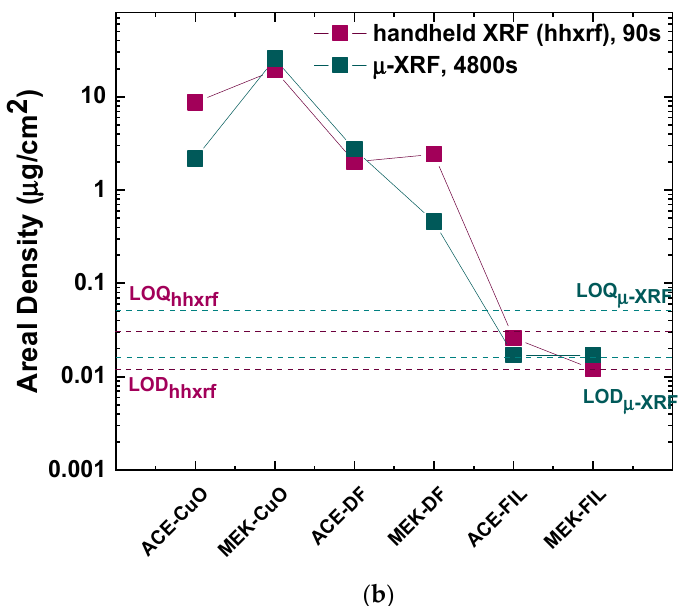
Figure 8. ( a ) Synopsis of µ -XRF measurements for all Phase 2 CuO/PMMA samples. The corresponding measurements of 1%CuO-1k and 1%CuO-1k-DF from Phase 1 have been included for comparison. Scattered solid diamonds depict the intensity signal from each point, while open squares show the average signal value. The large rectangles show the range between 25% and 75% of the maximum obtained signal, the crosses mark the range between 1% and 99% of the maximum obtained signal and the horizontal dashes the minimum and maximum obtained values. Dashed lines show the limit of detection (LOD) and the limit of quantification (LOQ) set as 3*LOD. ( b ) Comparison of the calculated Cu areal density by the hh-XRF analyzer (magenta bars) and the µ -XRF spectrometer system (green bars). Dashed lines denote the LOD and LOQ determined for measurement times of 4800 s and 90 s for the μ -XRF and hh-XRF spectrometers, respectively.